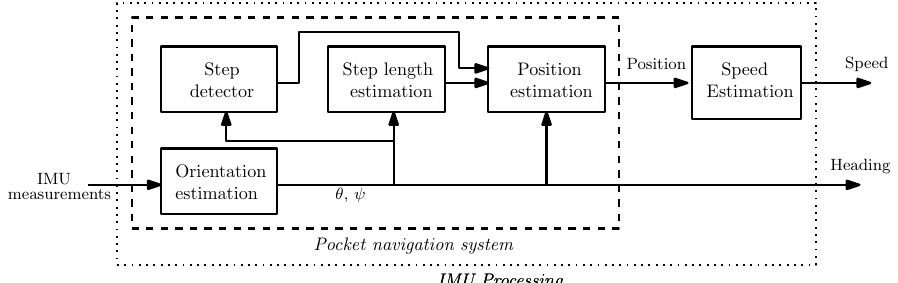
Figure 2. IMU processing block. The heading is estimated directly by the pocket navigation system. The speed is derived through the position estimate of the pocket navigation